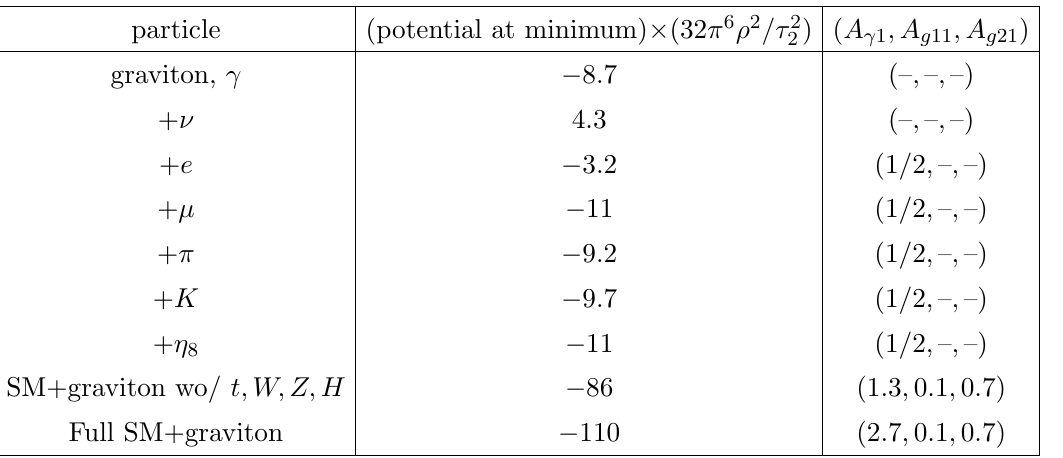
Figure 13 . A schematic picture of the perturbatively stable vacuum structure of T 2 compacti(cid:12)ca- tion of U(1) gauge theory with neutral matter.